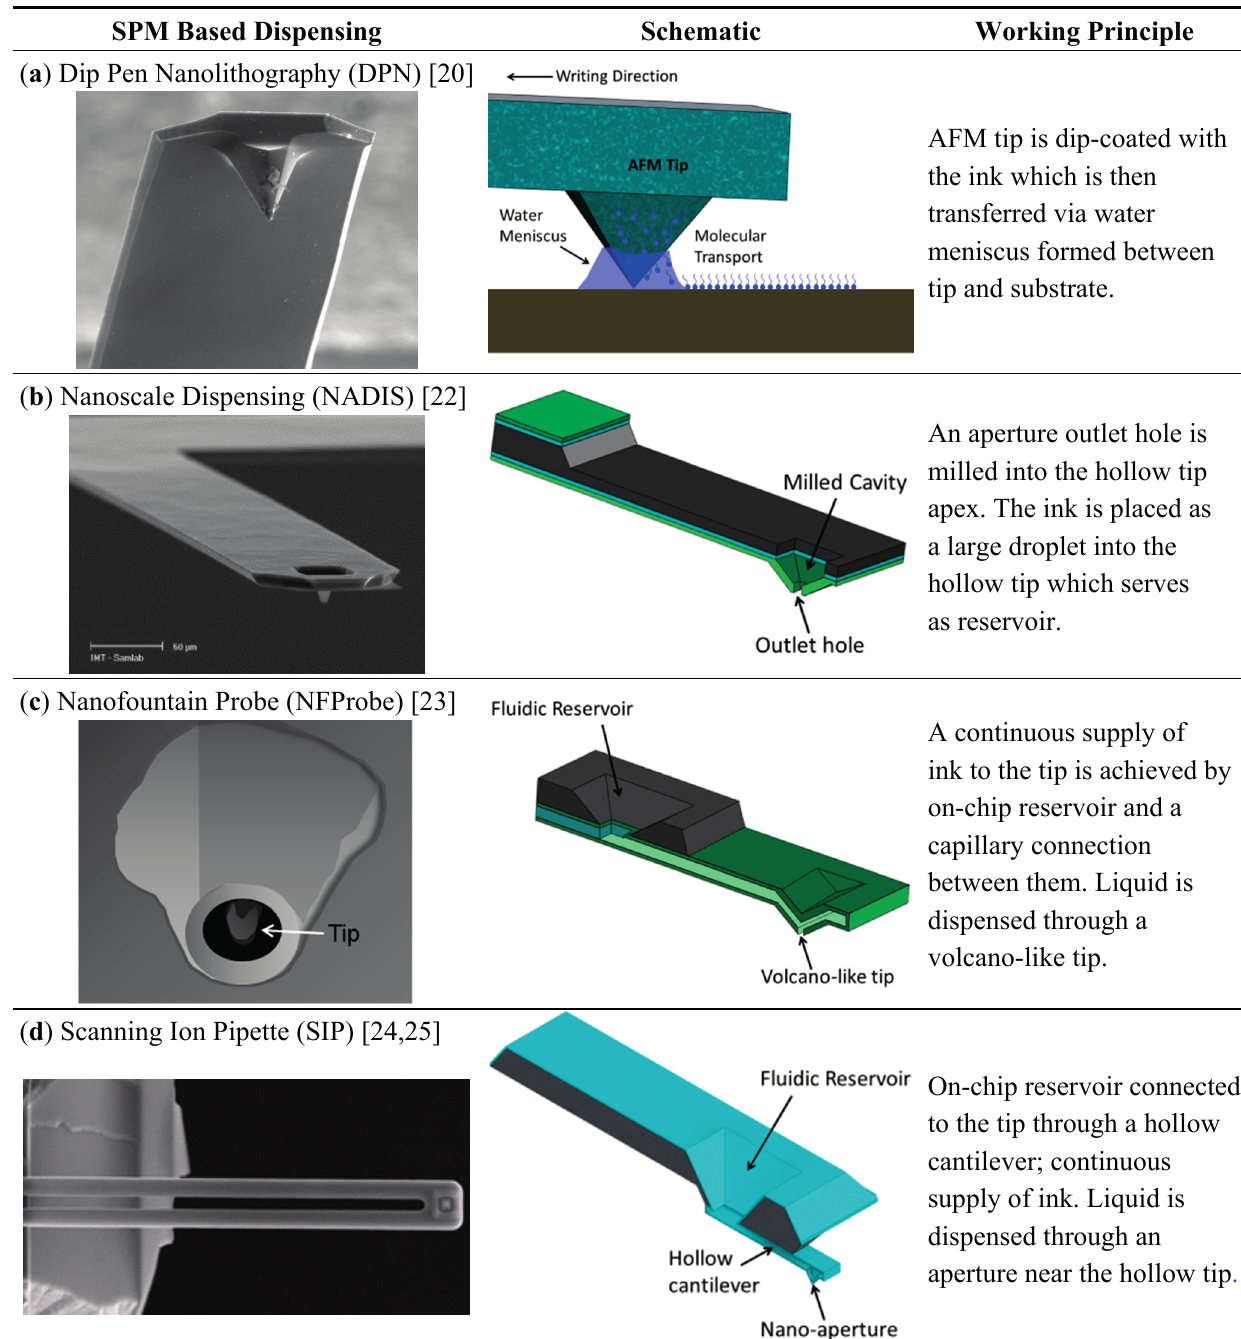
Table 1. Different types of scanning probe microscope (SPM) based nanoscale fluid handling